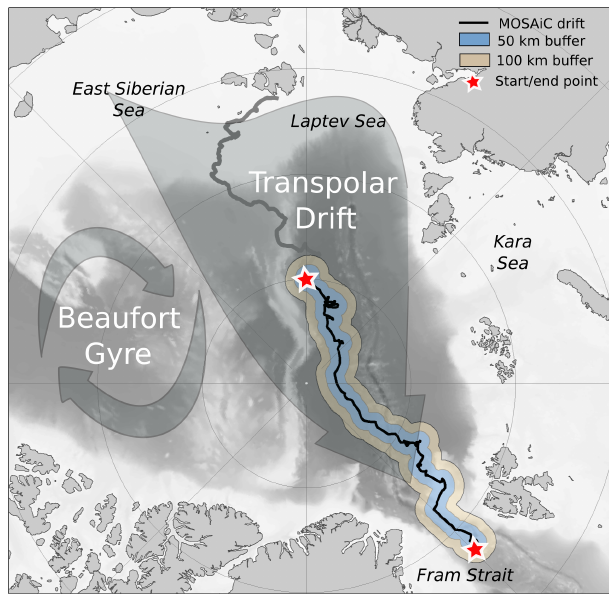
Figure 1. The MOSAiC drift (black line; the Central Observatory, CO) with a 50km (blue) and 100km (orange) buffer. The start (4 October 2019) and end points (31 July 2020) of the first MOSAiC expedition phase are indicated by red stars. Following Krumpen et al. (2020), the MOSAiC floe originated from the New Siberian Is- lands (thick gray line). The bathymetry of the Arctic Ocean (gray shading in the background) is based on Jakobsson et al.